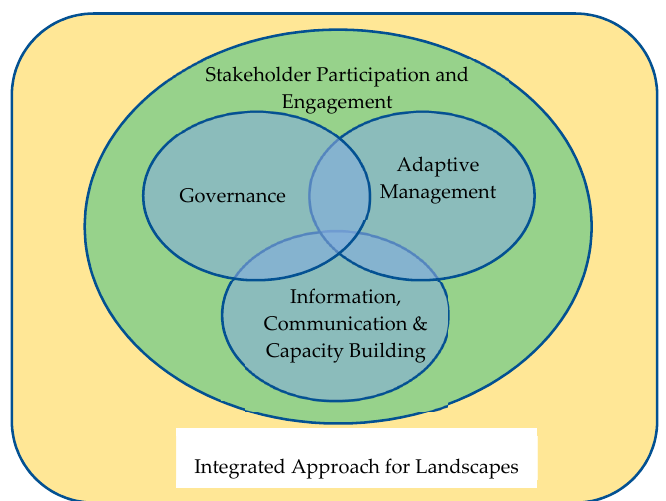
Figure 2. Analytical framework for a study on the potential of biosphere reserves for landscape governance and management.